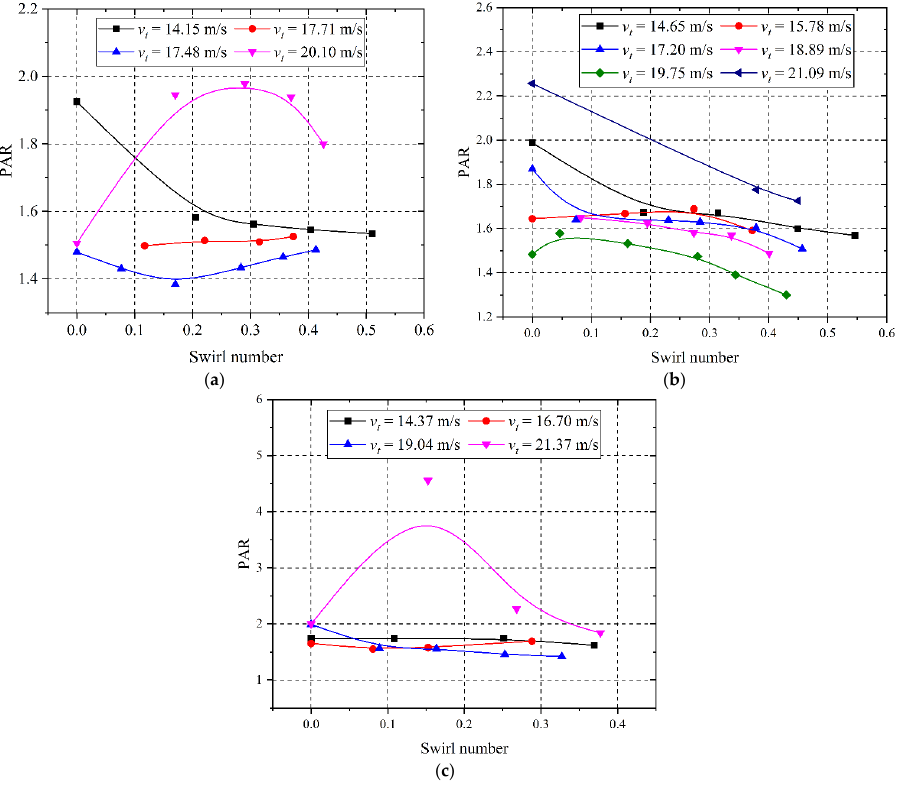
Figure 17. Effect of swirl number on peak to average ratio of pebble particles. ( a ) d p = 3 – 5 mm, ( b ) d p = 5 – 7 mm, ( c ) d p = 7 – 9 mm.